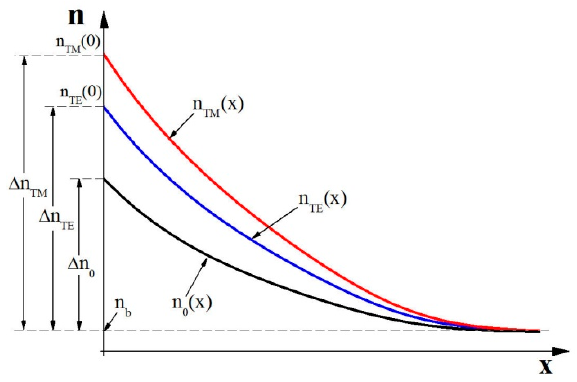
Figure 2. Refractive index profiles in a planar waveguide showing birefringence.